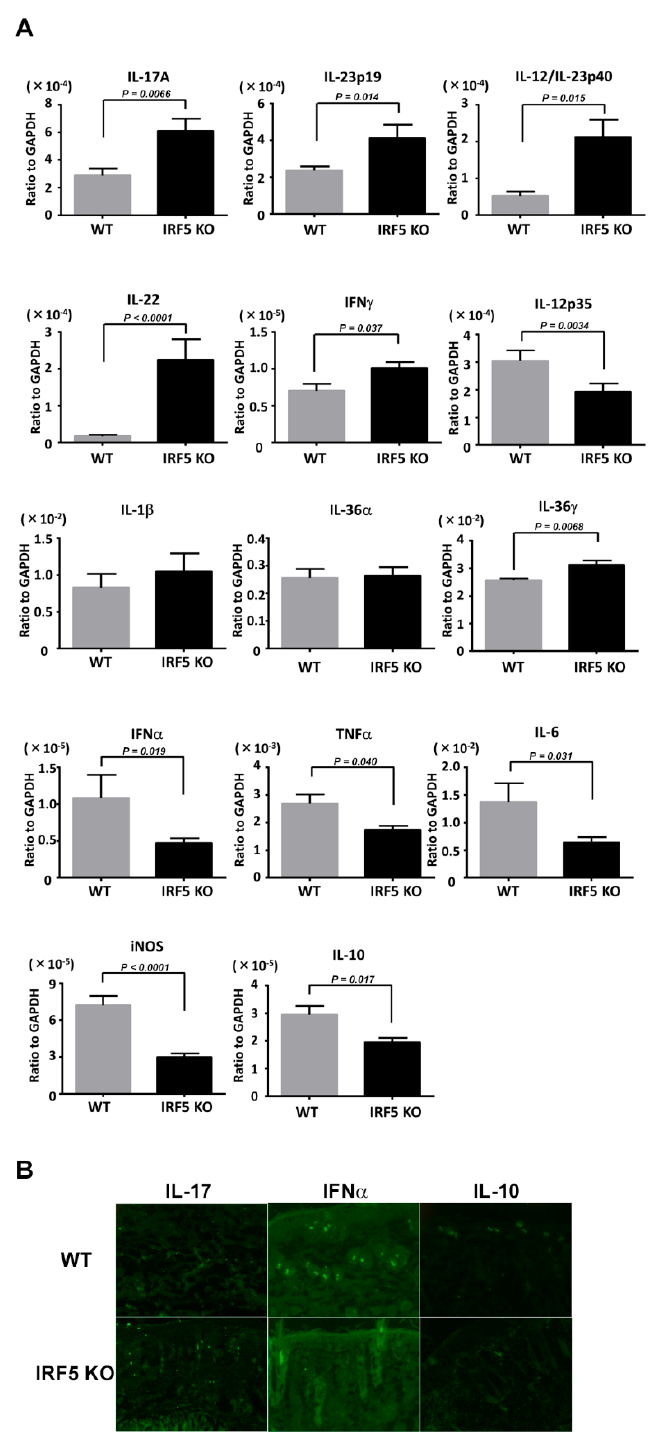
Figure 3. Th17 cytokine expression levels were upregulated and the IL-10 levels were downregulated in the IRF5-deficient mice. ( A ) Wild-type (WT) and IRF5 knockout (IRF5 KO) mice were applied with imiquimod and skin samples were taken 48 h after imiquimod application. Messenger RNA levels of the indicated cytokines were determined by quantitative RT-PCR. Data are obtained from duplicate samples from 12 mice in each group. Values are presented as the mean ± SEM of three independent experiments. ( B ) Immunofluorescent staining of IL-17A, IFN- α and IL-10 of wild-type (WT) and IRF5 knockout (IRF5 KO) mouse back skin induced by imiquimod application at day 5 ( × 240). Representative pictures from 5 mice per